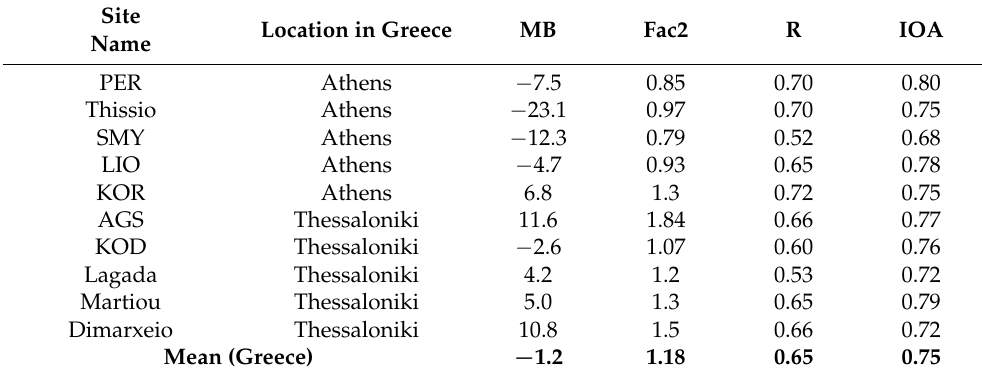
Table 2. Statistical metrics for O 3 mean daily concentrations ( µ g/m 3 ) for each monitoring site over Thessaloniki, Greece (for d03 domain, 2 × 2 km 2 ) and the rest of Greece (for d02 domain, 6 × 6 km 2 ) for the cold period of 2015 (January–April, October–December) for the